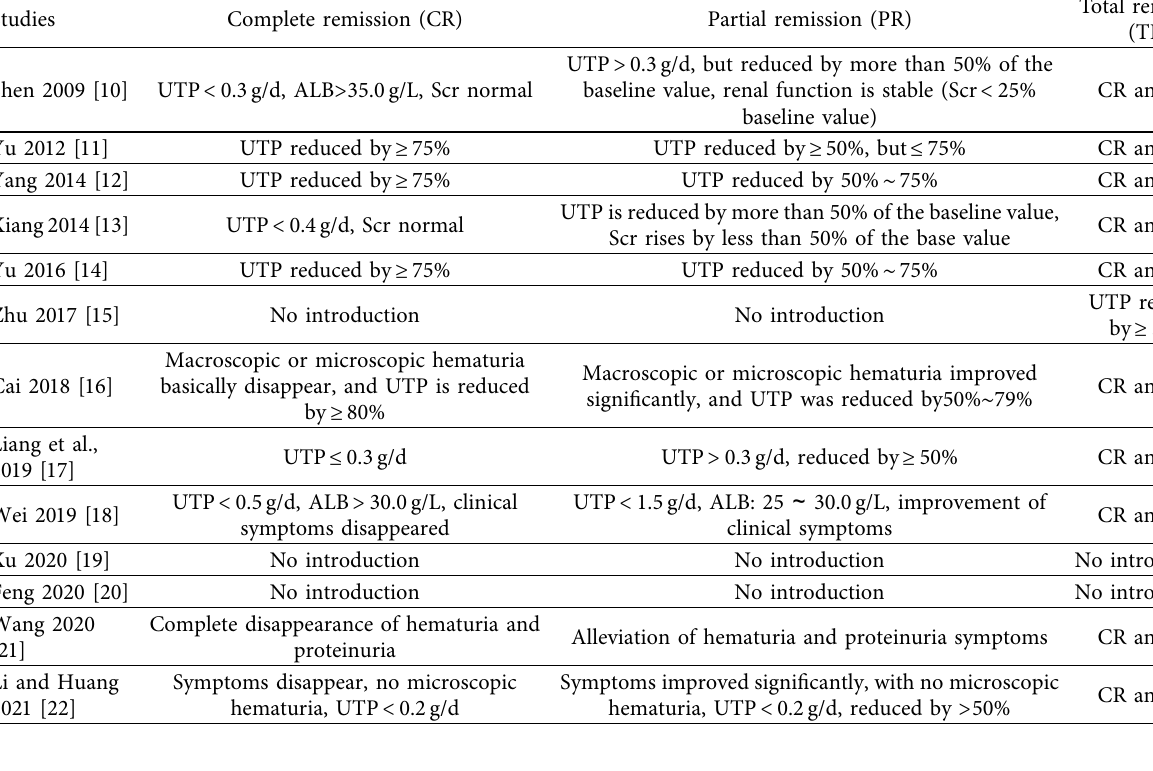
Table 2: Definition of clinical outcomes in each study.